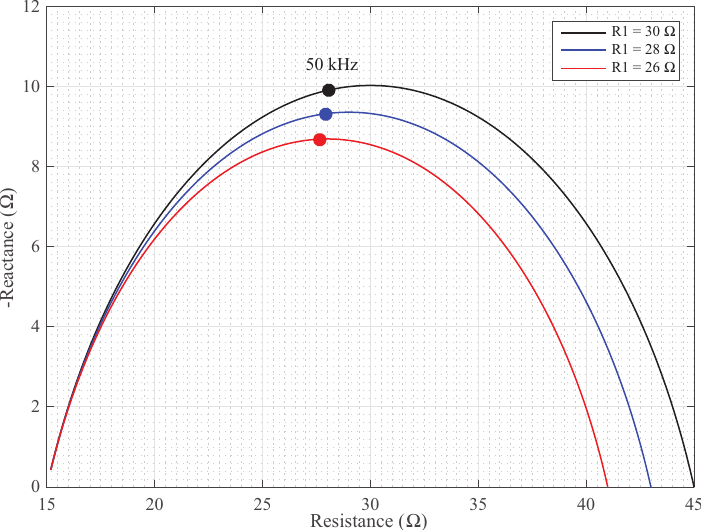
Figure 5. Simulated Cole-impedance with R ∞ = 15 Ω , C = 3 µ F sec ( α − 1 ) , α = 0.75 and R 1 = 30 Ω (black), 28 Ω (blue), and 26 Ω